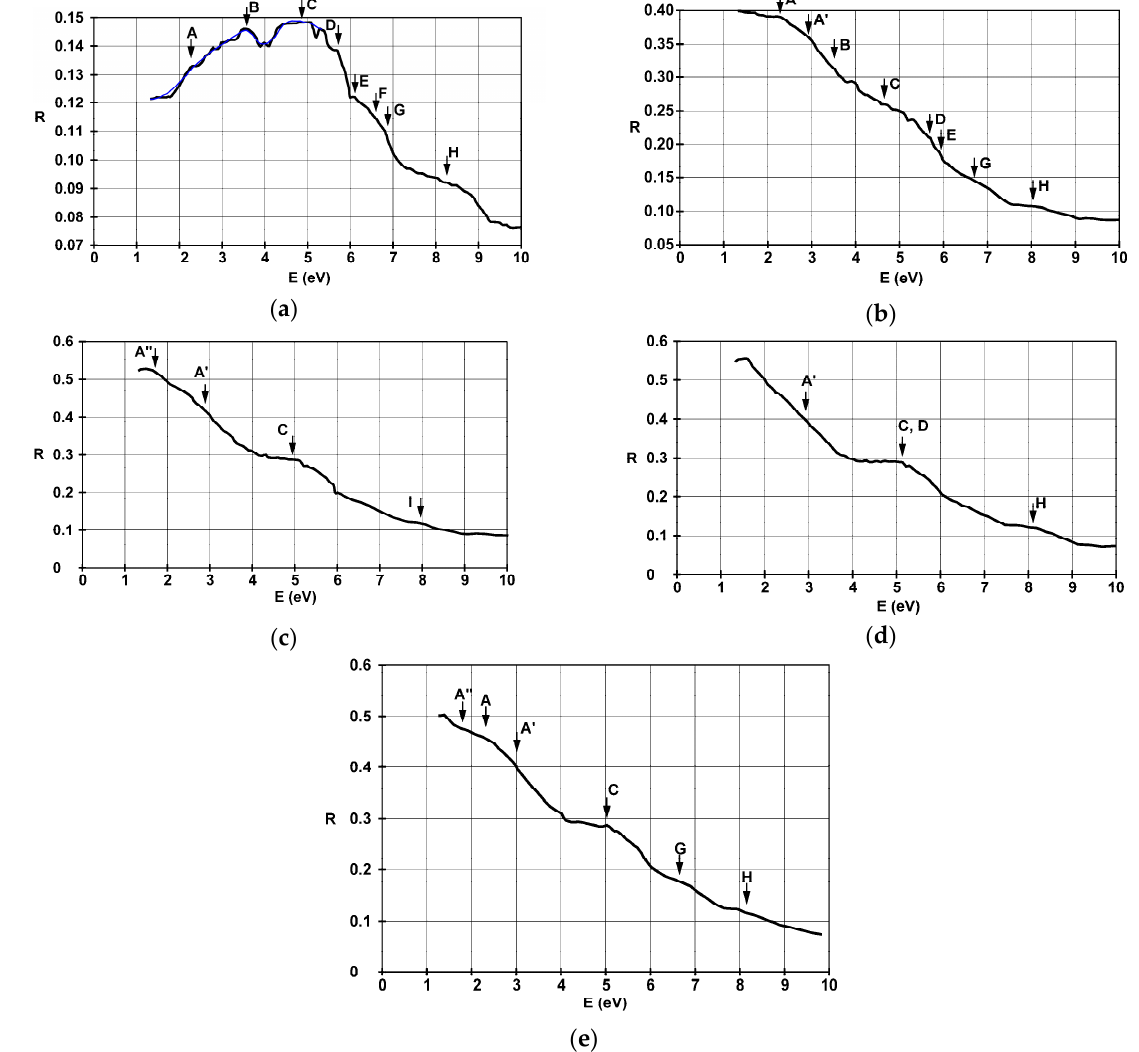
Figure 6. Spectral dispersion of reflectance, with substrate contribution removed, for the films deposited on glass substrate with thicknesses of ( a ) 4.5 nm, ( b ) 22 nm, ( c ) 38 nm, ( d ) 42 nm, and ( e ) 36 nm on SiO 2 . The blue curve in part ( a ) represents the computed behavior using the Lorenz-Drude model for a dielectric . Table 1. Allowed interband transitions identified in the spectral behavior of reflectance. Identified Allowed Interband Transitions (eV) Film Substrate Thickness Glass